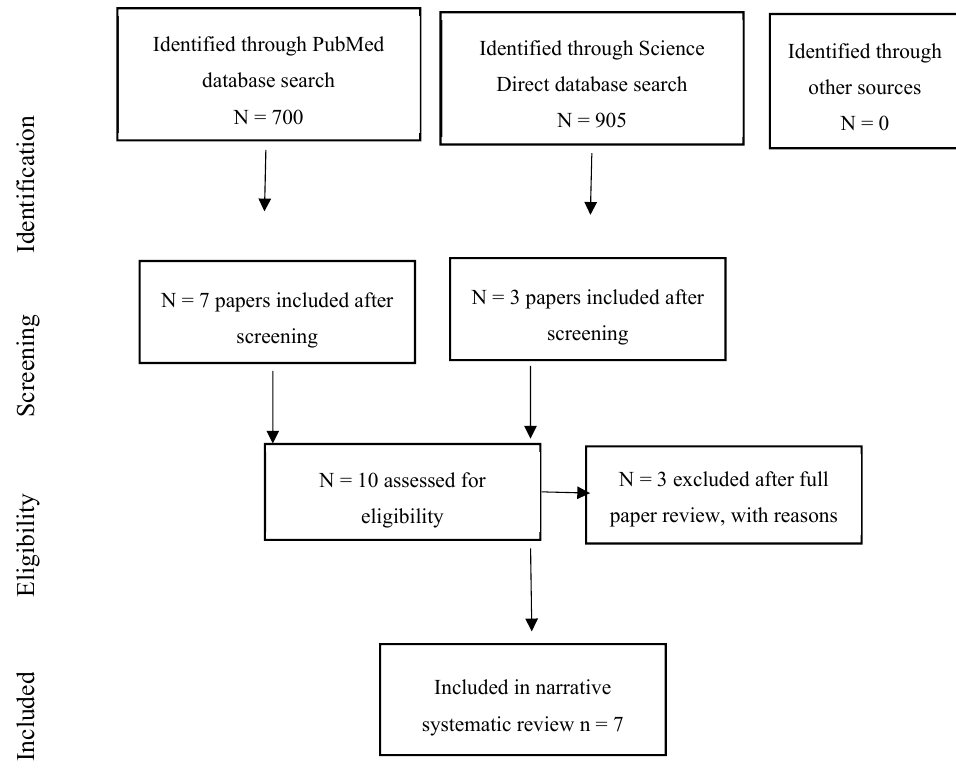
Figure 4. Flow chart showing the review process for birth outcome papers.